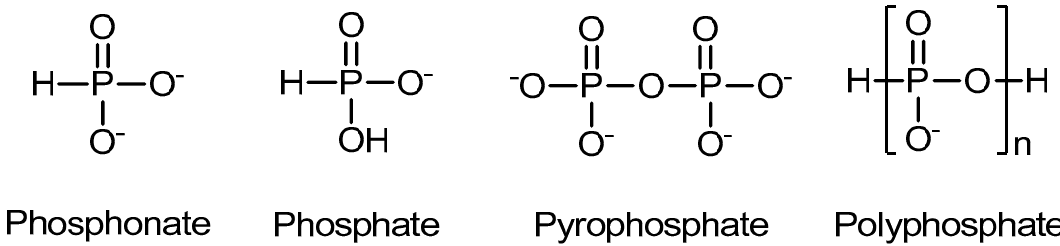
Figure 1. Chemical structure of the class of phosphorous compounds.